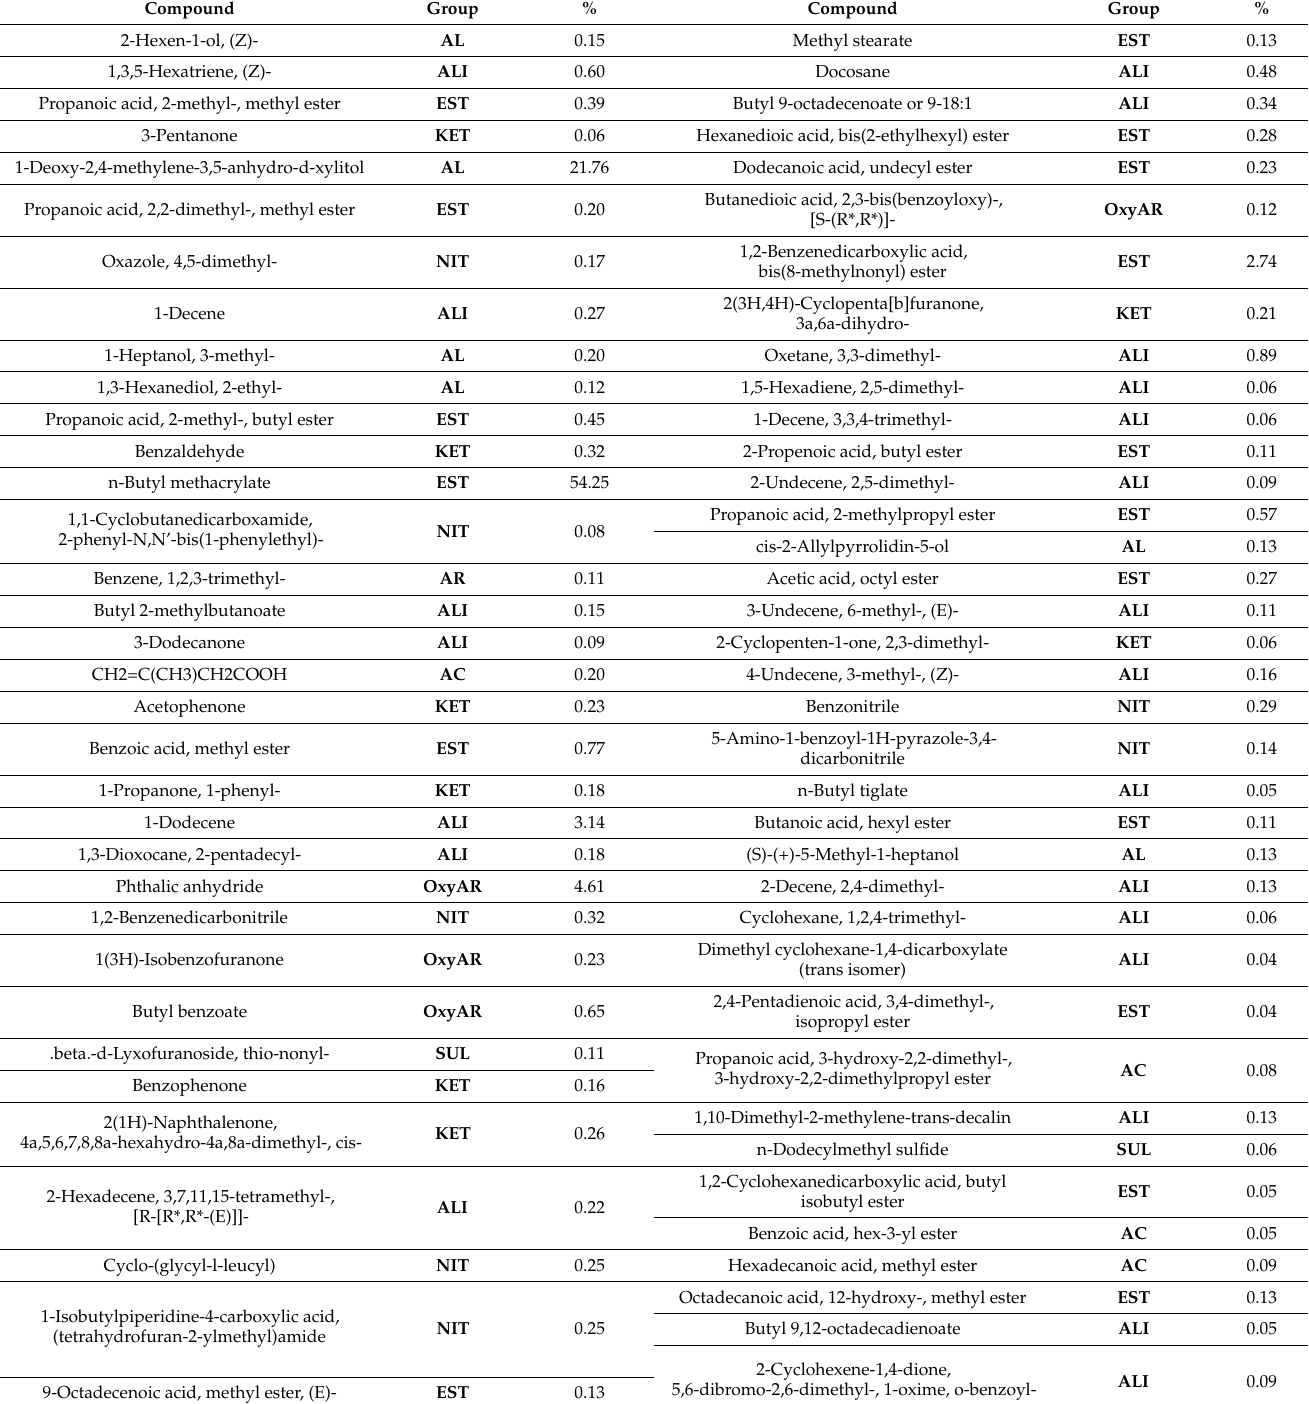
Table 2. Composition of bio-oil derived from non-catalytic fast pyrolysis of residual paint (NAS-2) in the Py/GC-MS system, at 600 ◦ C (GC-MS peak area,